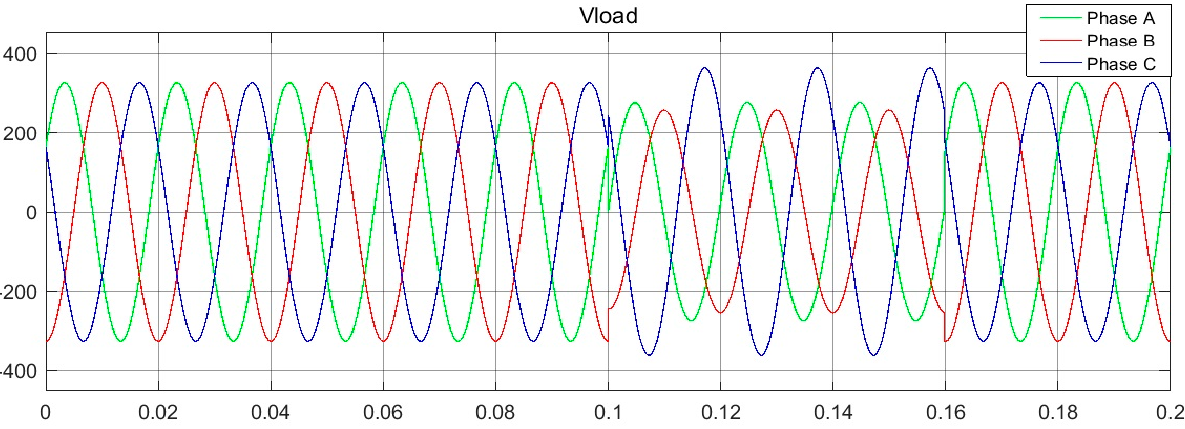
Figure 8. Voltage sag (Phases A and B) and swell (Phase C) waveforms.